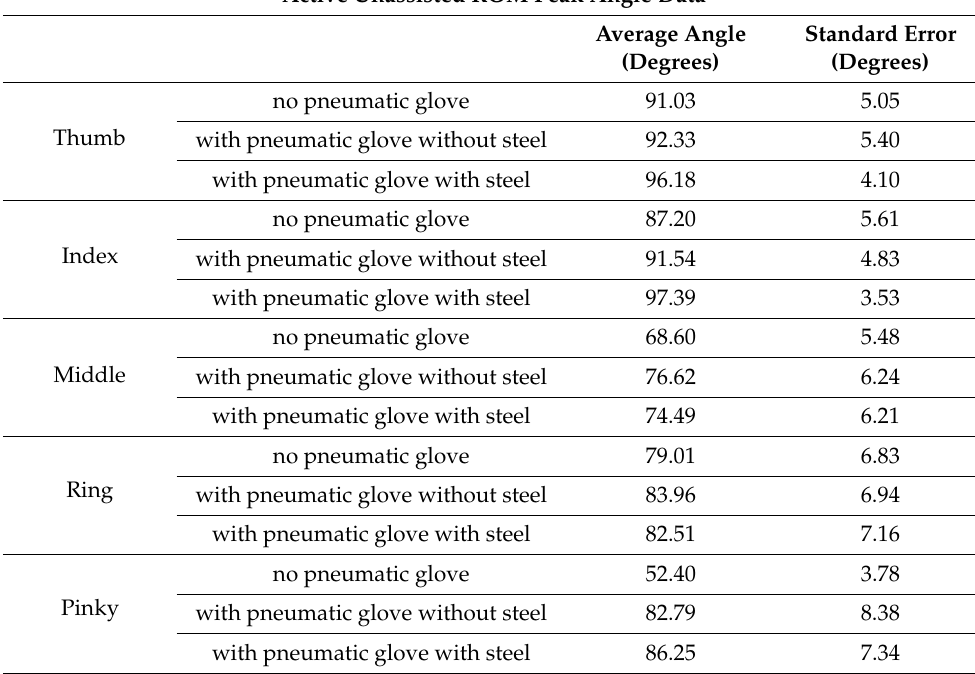
Table 3. Average maximum angle in degrees for 10 subjects’ ROM trials comparing 3 cases of no pneumatic glove, with pneumatic glove without steel, and with pneumatic glove with